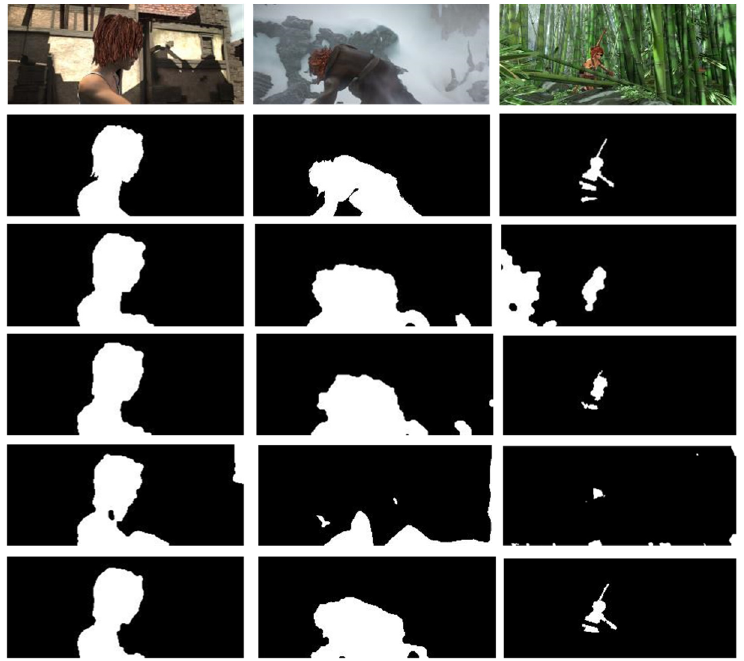
Figure 9. Comparison of the HS pyramid, B&A, Brox, and the optical flow method with this study’s thresholding method and morphological operation results. The top-to-bottom regions present the current image, true moving target areas, HS result, B&A result, Brox result, and this study’s results.